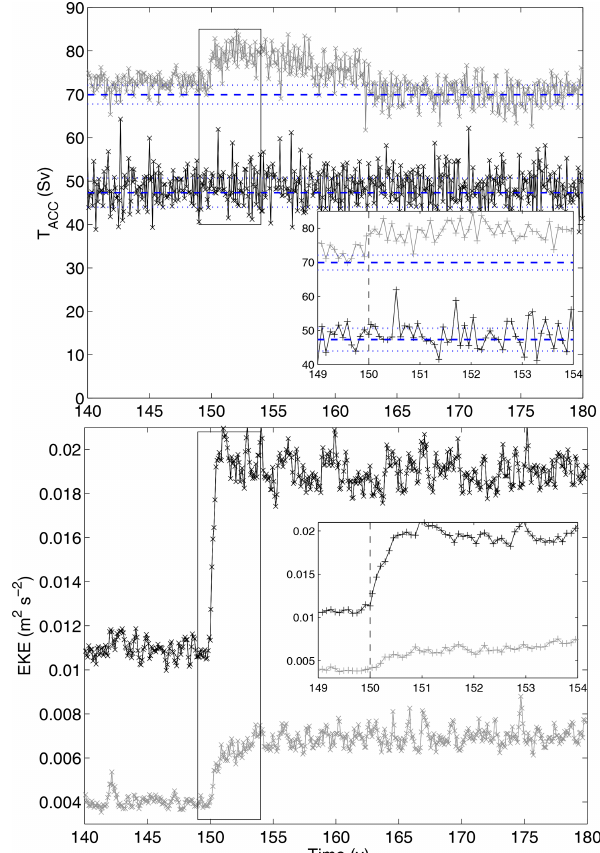
Figure 12. Times series of zonal transport (Sv) and total kinetic energy (m 2 s − 2 ) for simulations R + F (black lines) and R + R (gray lines) in response to an abrupt doubling of the wind stress at year 150. Inset provides details for the years 149–204. The blue dashed (resp. dotted) lines represent the average (resp. average ± 1standard deviation) transport between years 130 and